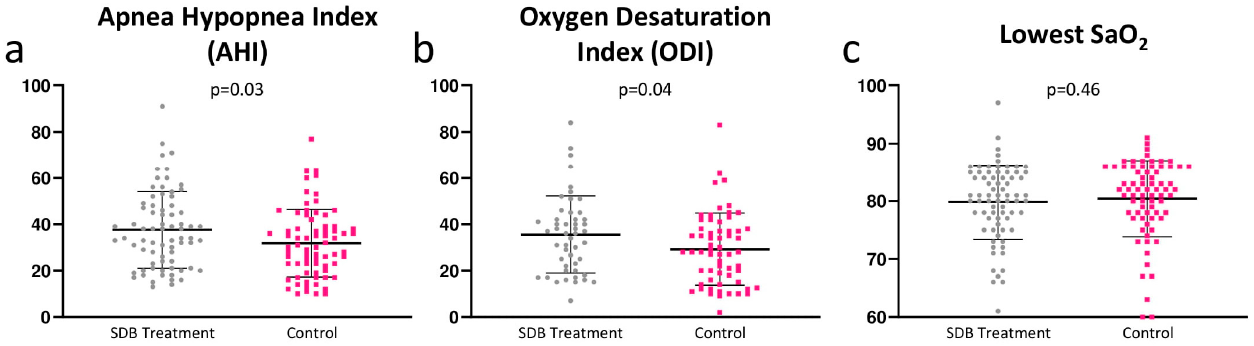
Figure 2. Patients with heart failure and defibrillator therapy presented with a severe sleep-disordered breathing at baseline as expressed in ( a ) Apneo Hyponea Index, ( b ) oxygen desaturation index